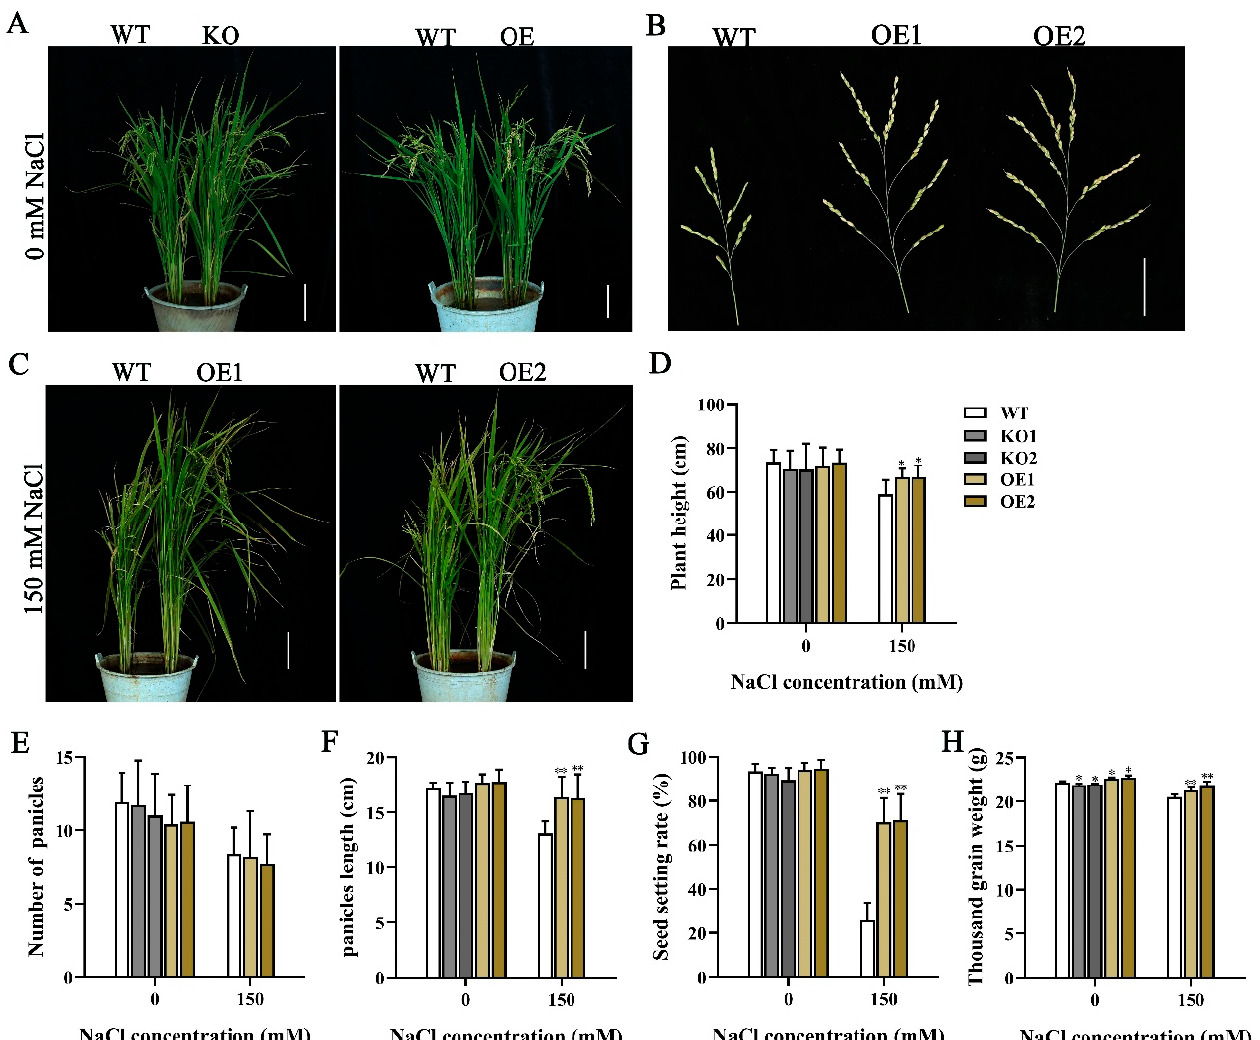
Figure 4. OsJRL40 enhances salt tolerance of rice plants at the reproductive stage. ( A – C ) Phenotypic comparison of WT, KO1, KO2, OE2, and OE2 plants under normal (0 mM NaCl) and salt stress (150 mM NaCl) conditions. Scale bar = 5 cm. ( D – H ) Plant height ( D ), effective panicle number ( E ), main panicle length ( F ), seed setting rate ( G ) and thousand grain weight (H) of WT, KO1, KO2, OE2, and OE2 plants. Data represent mean ± SD ( n = 10), and asterisks indicate statistically significant differences (* p < 0.05, ** p < 0.01; Student’s t -test).